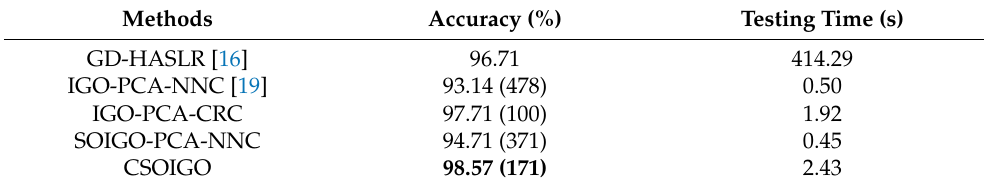
Table 6. Recognition accuracy (%) and testing time (s) of compared approaches with mixed variations on a subset of the AR database (training and test samples have expression and illumination changes). The dimension that leads to the best result for IGO- and SOIGO-based approaches is given in